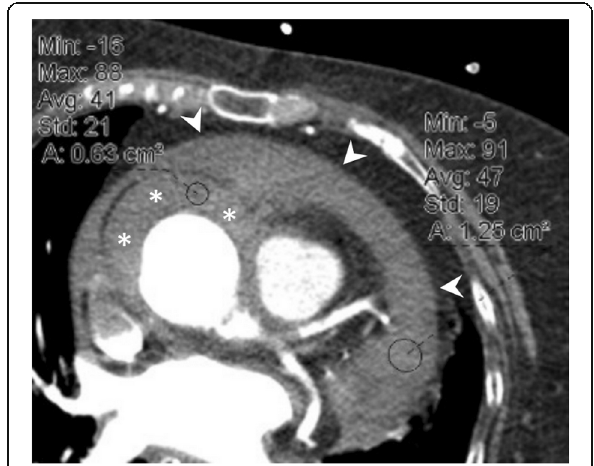
Fig. 6 A 86-year-old woman with acute onset of pain in the chest. Axial contrast-enhanced CT image reveals hemopericardium (arrowheads) and intramural hematoma of the ascending aorta